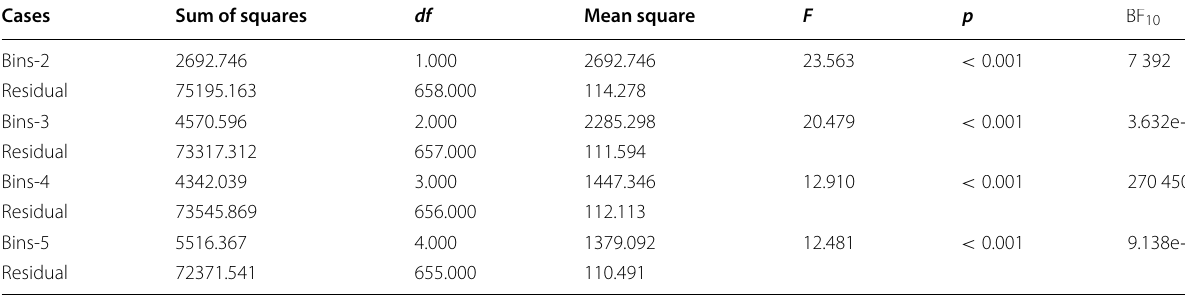
Table 3 Summary of ANOVA results—fixed continuous Price